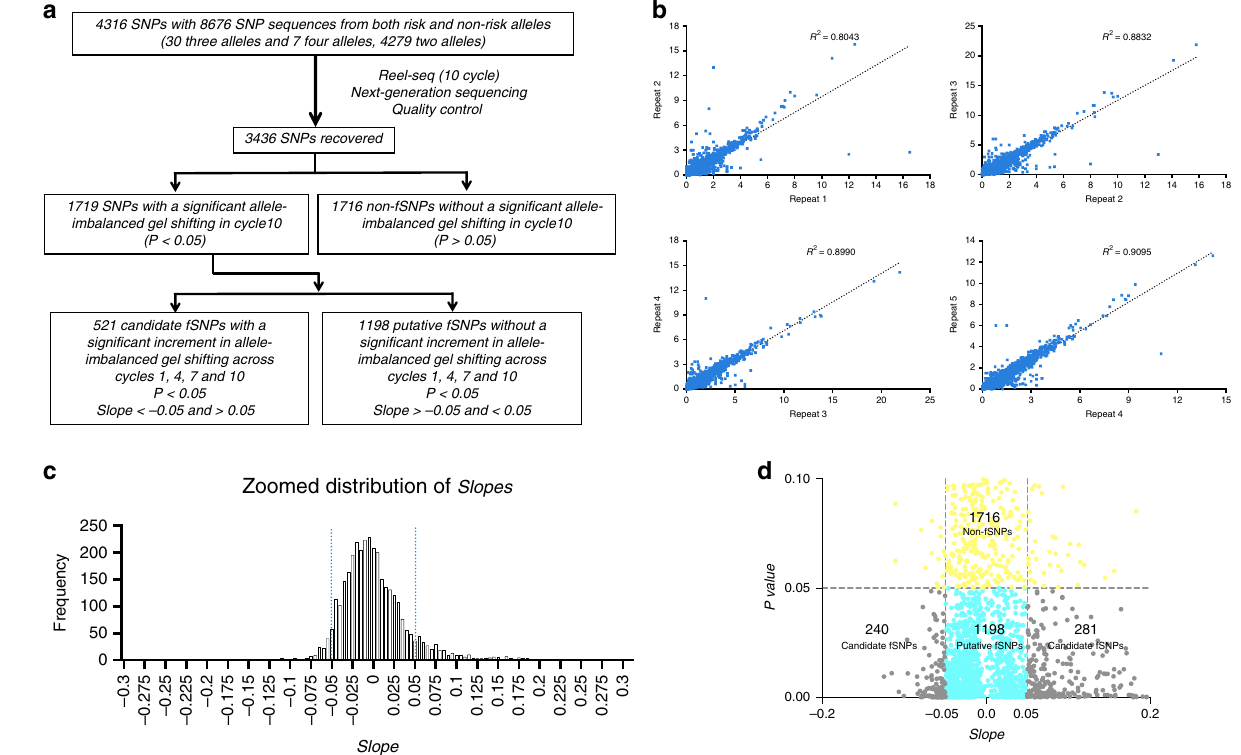
Fig. 2 Reel-seq screen on 4316 BC-associated SNPs on 177 loci. a Outline of the Reel-seq screen. b Correlation between technical replicates. The ratios of the raw data from fi ve samples versus fi ve controls at cycle 10 were plotted along the x and y axis with R 2 = 0.80 for Repeat1/2; R 2 = 0.88 for Repeat2/3; R 2 = 0.89 for Repeat3/4; R 2 = 0.90 for Repeat4/5. c Histogram of Slopes in Reel-seq data analysis showing an empirical cutoff line (Blue) with − 0.05 > Slope > 0.05 (zoomed distribution of Slopes between − 0.3 and 0.3 in Slopes ). d Dot plot of P value and Slope of 3436 SNPs to identify fSNPs. Candidate fSNPs (gray) with P value < 0.05 and − 0.05 > Slope > 0.05; Putative fSNPs (light blue) with P value < 0.05 and − 0.05 < Slope < 0.05; and non-fSNP (yellow) with P value > 0.05. The data was drawn to fi t the fi gure. The full-size plot is in Supplementary Fig. 1. P value for HTP Reel-seq screen was calculated with fi ve technical replicates using Student ’ s t test with two tails without correction for multiple hypothesis testing. Source data are available in the Source Data fi